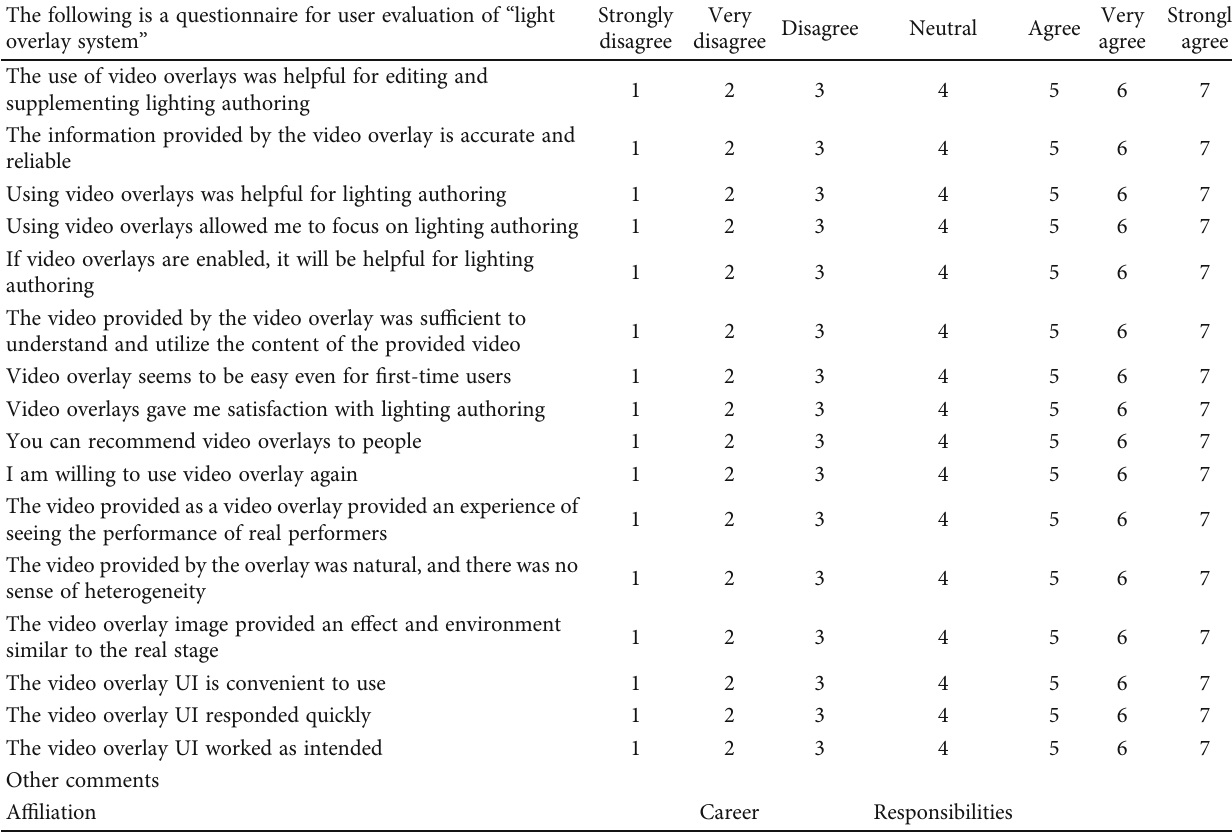
Table 2: Questionnaire for user evaluation of light